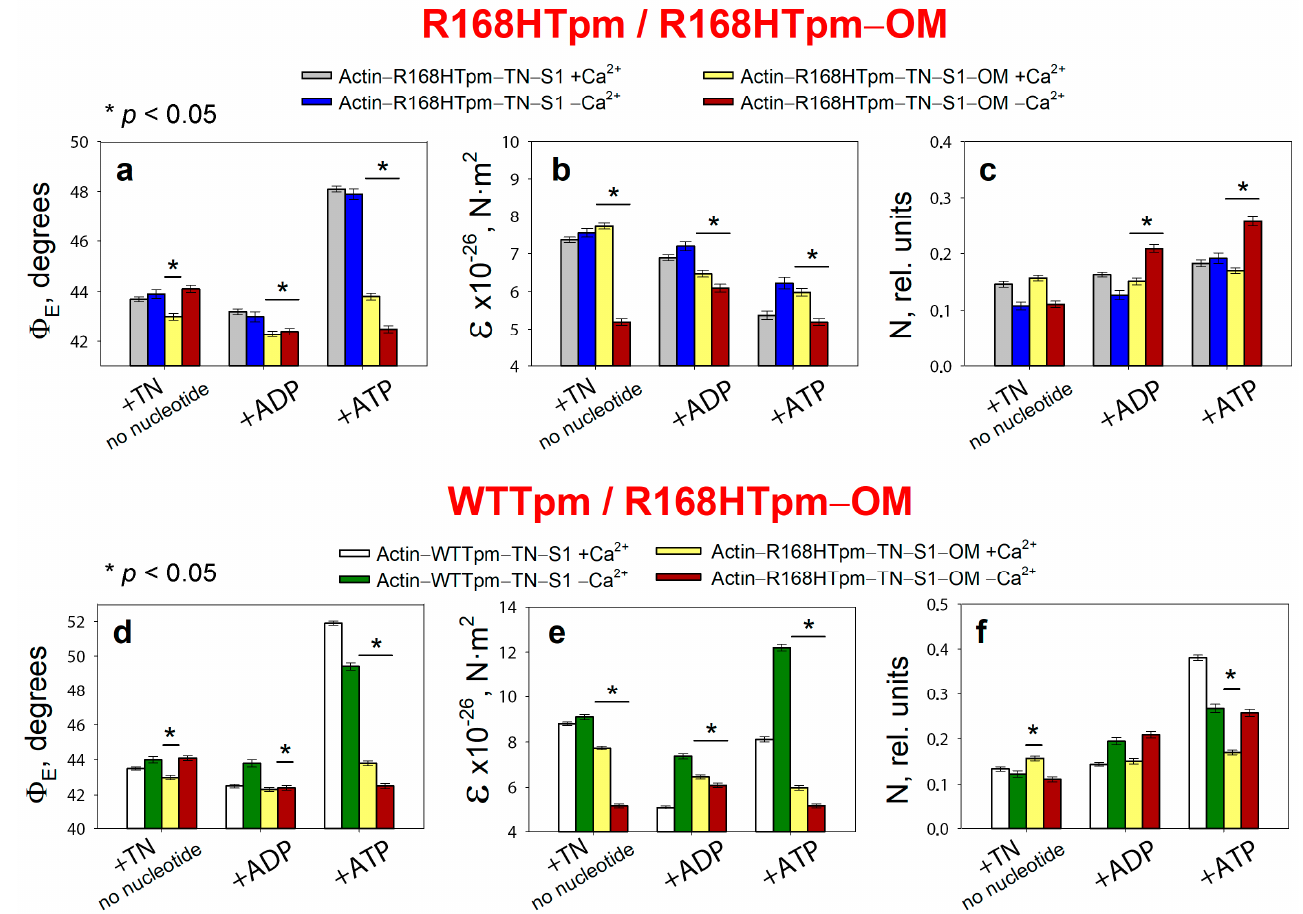
Figure 6. Effect of 20 μ M omecamtiv mecarbil (OM) on the values of Φ E ( a ), ɛ ( b ), and N ( c ) of polarized fluorescence of S1-AEDANS in the presence of WTTpm or R168HTpm revealed in ghost muscle fibers under conditions simulating the sequential steps of the actomyosin ATPase cycle. The comparison of the effect of OM is given for two series of experiments, when the muscle fibers containing the R168HTpm ( a – c ) or WTTpm ( d – f ) without OM were used as a control. The data are presented as mean ± SEM. * p < 0.05 = difference between R168HTpm and R168HTpm–OM ( a – c ), and WTTpm and R168HTpm–OM ( d – f ).